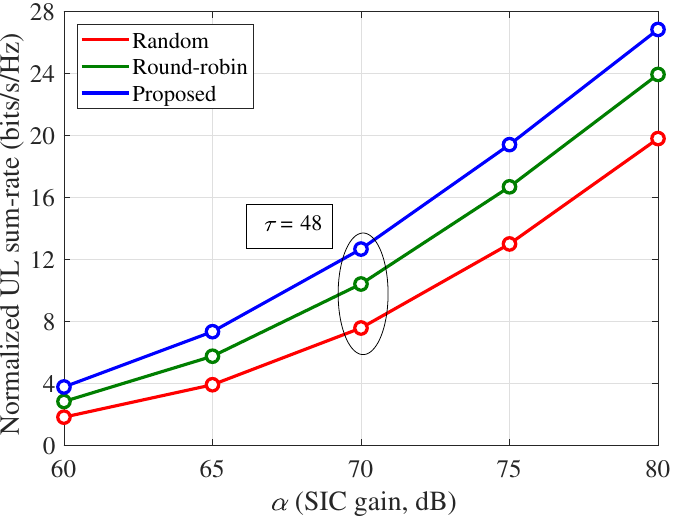
Figure 9. Normalized UL sum-rate ( η u ) per channel use according to the analog SIC gain ( α ): K u = 8, κ ij = 3, τ = 48, and 80 dB path loss between the BS and